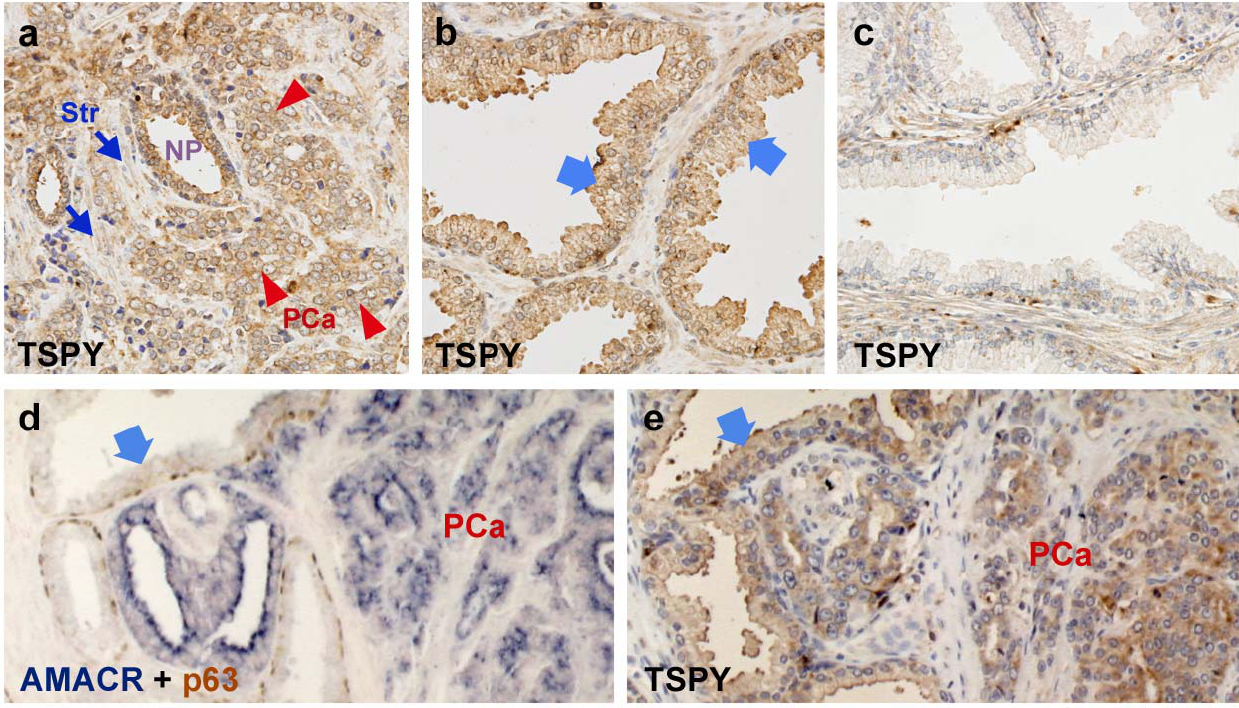
Figure 2. Immunohistochemical localization of TSPY and other biomarkers in the prostate tissues. (a) Immunostaining of TSPY (brown) in prostatic adenocarcinoma. Nuclei were counterstained by hematoxylin (purple). Note significant TSPY staining in cancer cells (red arrowheads), and faint or negative staining in the surrounding stromal cells (blue arrows). ‘NP’ indicates the TSPY-positive normal prostate gland. (b) Image of normal gland adjacent to cancer area in the same clinical prostate cancer section of (a). Epithelial cells in normal gland were also positively stained (arrows). (c) Representative image of TSPY immunostaining in the TSPY-negative gland of normal prostate. (d) Clinical prostate cancer section doubly immunostained for AMACR (dark blue) and p63 (brown). Arrow indicates the morphologically normal glands containing AMACR-negative epithelial cells and p63-positive basal cell layers. ‘PCa’ indicates the AMACR positive cancer area. (e) An adjacent section of d immunostained by anti-TSPY. Arrows indicate the AMACR-negative glands that were expressing TSPY. Scale bar = 75  m.